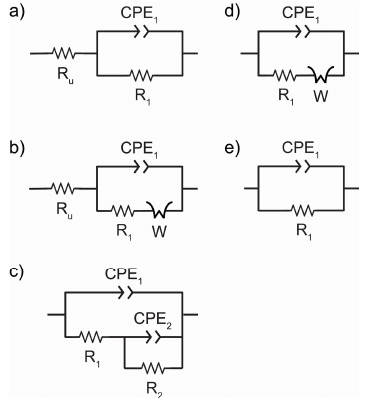
Figure A1. Equivalent circuit models used to for EIS spectra for PA ( a ), WA ( b ), WPA ( c ), W ( d ), and B44 ( e ). All resistor, constant phase element, and infinite Warburg parameters obtained from fitting are compiled in Table A1.